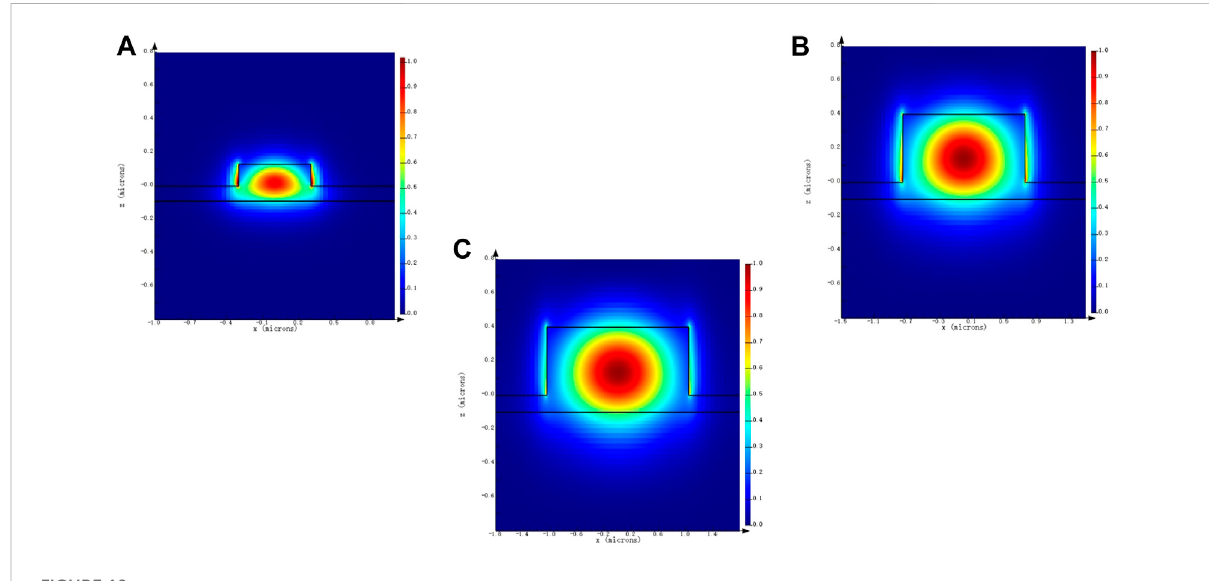
FIGURE 10 Distributions of optical fi elds of waveguides at (A) 2 μ m, (B) 4.3 μ m and (C) 5 μ m wavelengths.